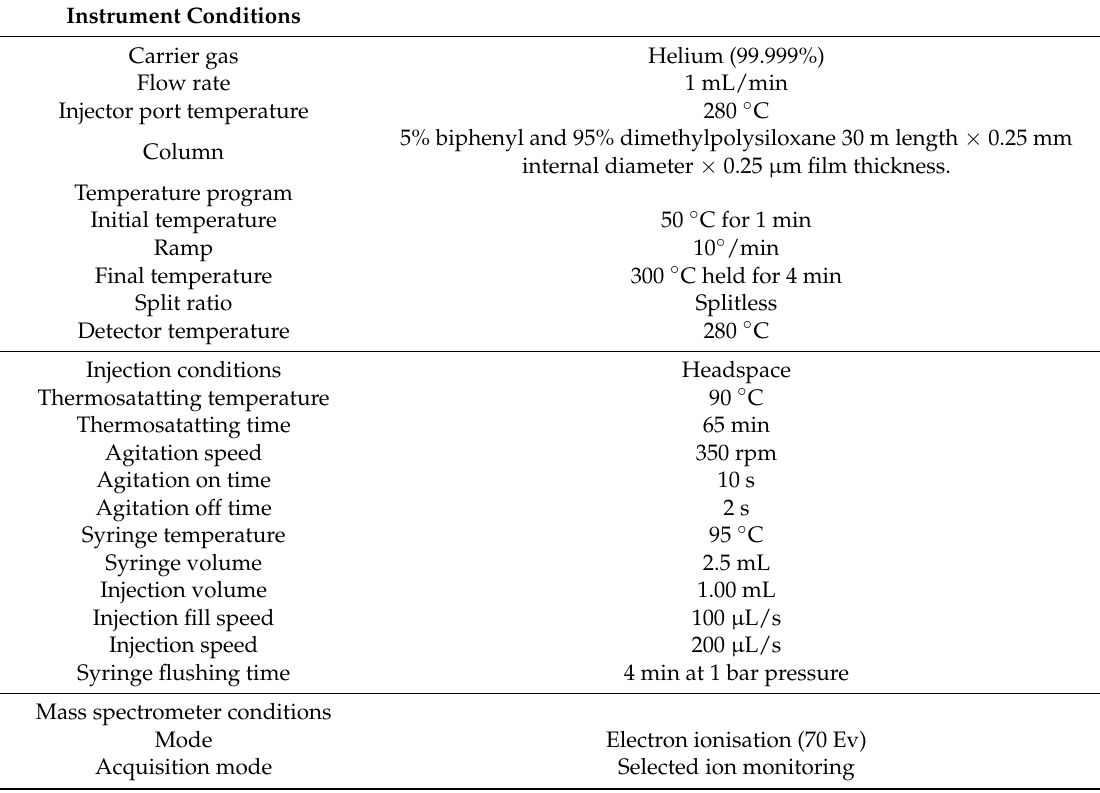
Table 1. GC/MS conditions used for the analysis of organotin